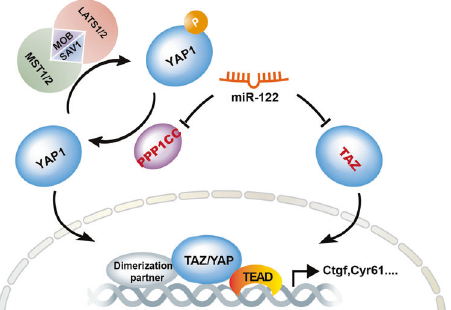
Fig. 7 Working model showing miR-122 positively regulates the Hippo pathway by targeting hippo regulators. Remarkably, on one hand, miR-122 can directly target the transcription co-activator Taz, on the other hand, miR-122 can in fl uence phosphorylation of YAP through targeting